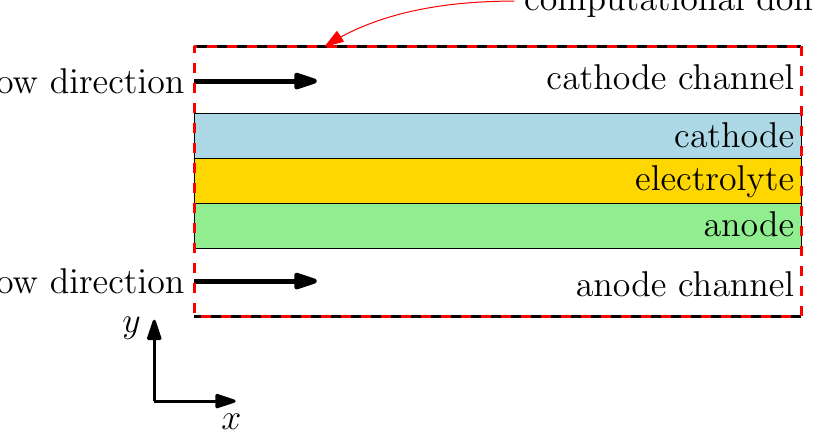
Figure 8. Computational domain for the SOFC simulations Table 8. Reference microstructure for the numerical